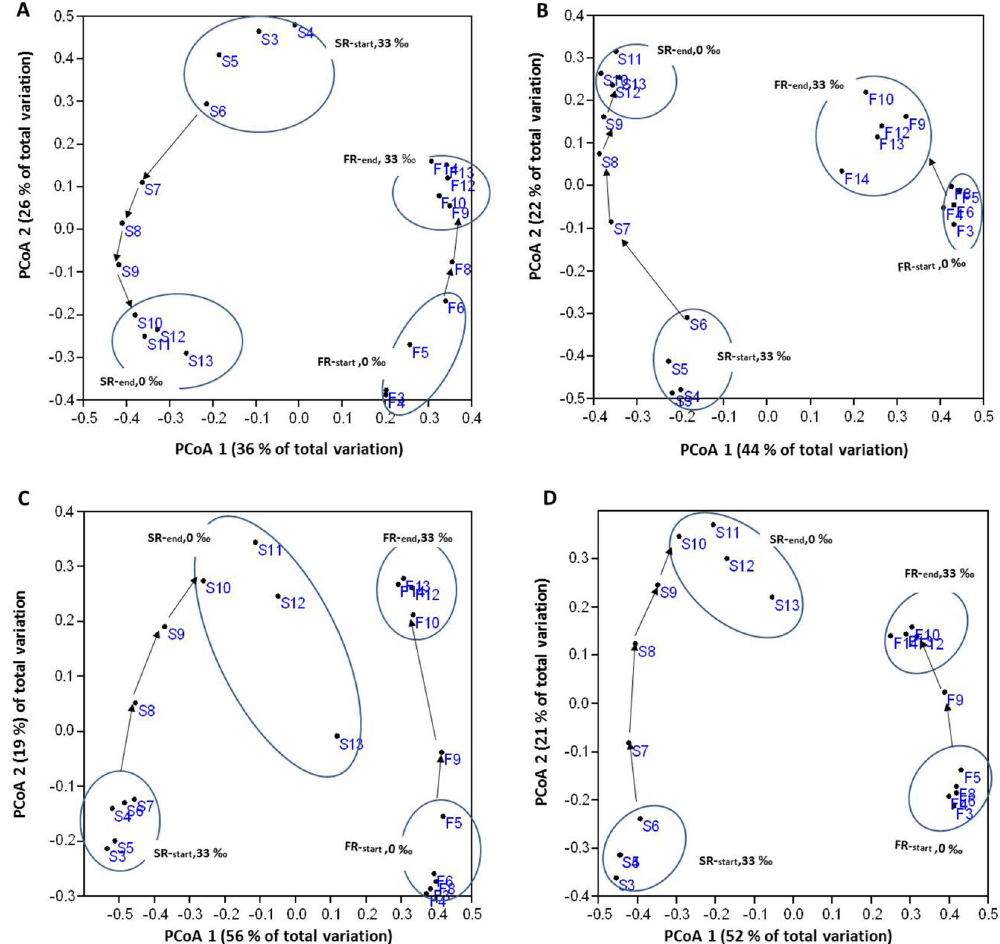
Figure 3. Principal coordinates analysis (PCoA) based on Bray–Curtis similarity of pyrosequencing data. F4– F14: samples from the freshwater reactor (FR); S3–S13: samples from seawater reactor (SR). ( A ) Based on total OTUs; ( B ) Based only on OTUs representing the AOB guild; ( C ) Based on OTUs representing the NOB guild, and ( D ) Based on OTUs representing the nitrifying community (AOB plus NOB guilds). Four groups of samples are identified FR start , FR end , SR start, and SR end . The arrows between each group show the time line for